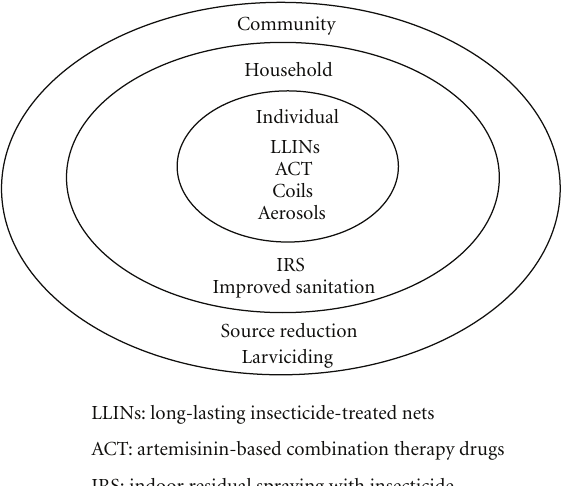
Figure 2: Interventions against urban malaria at the community, household, and individual